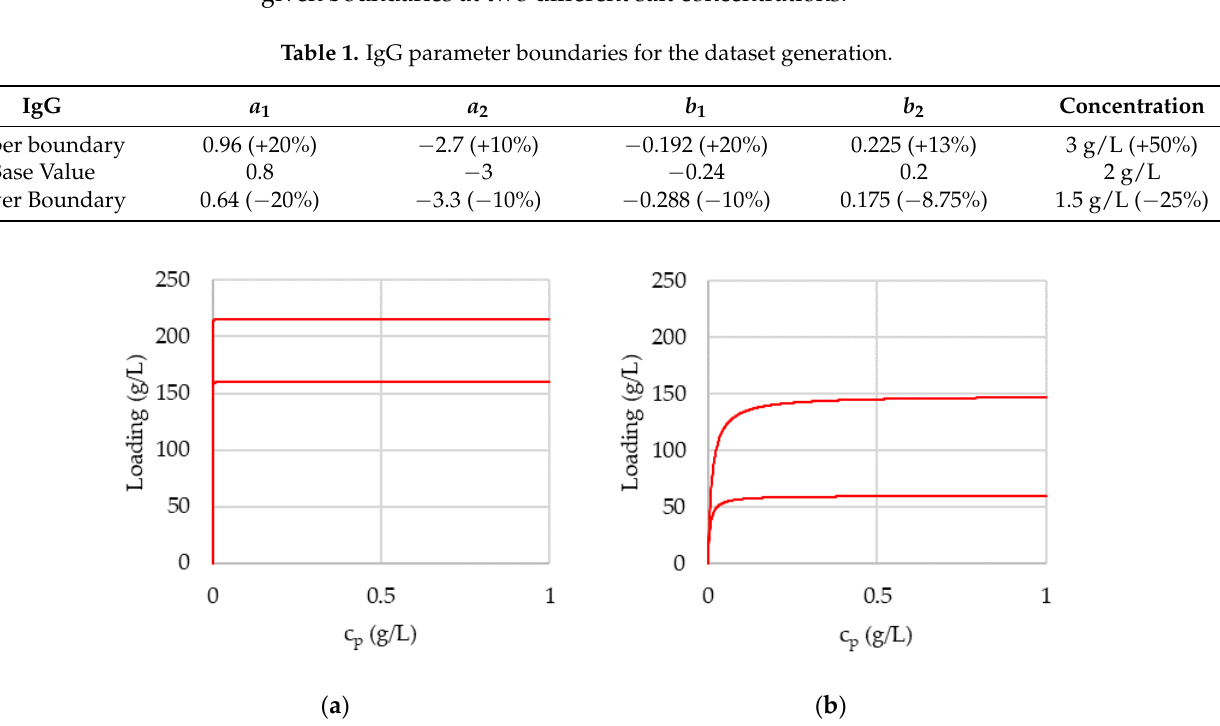
Figure 1. Enveloping isotherm curves of IgG with the parameters from Table 1: ( a ) at 0.05 mol/L salt concentration and ( b ) 0.6 mol/L salt concentration. Table 1. IgG parameter boundaries for the dataset generation.